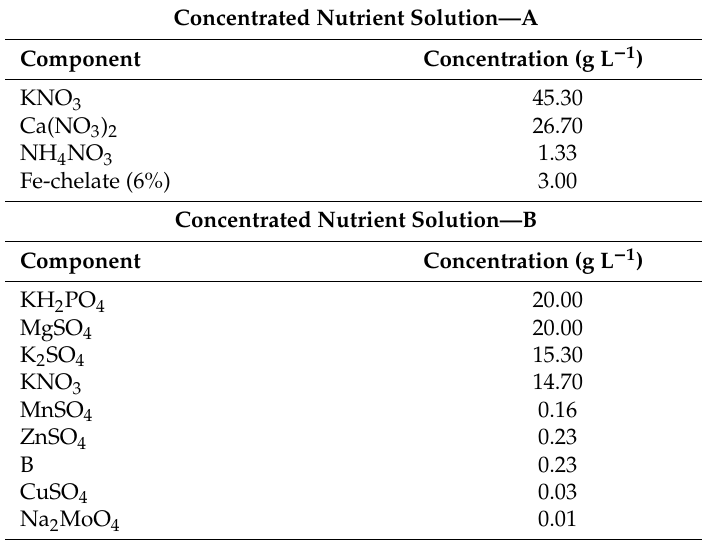
Table 1. Composition of the concentrated nutrient solutions (A and